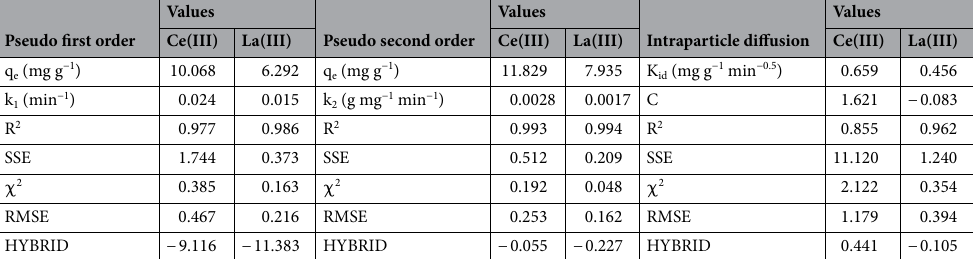
Table 7. Parameters of kinetic models for Ce(III) and La(III) Adsorption onto SIR ([Ce-La] = 200 mg/L, pH = 5, SIR dose = 0.4 g, Stirring speed = 200 rpm, and temperature = 25 ± 2 °C).